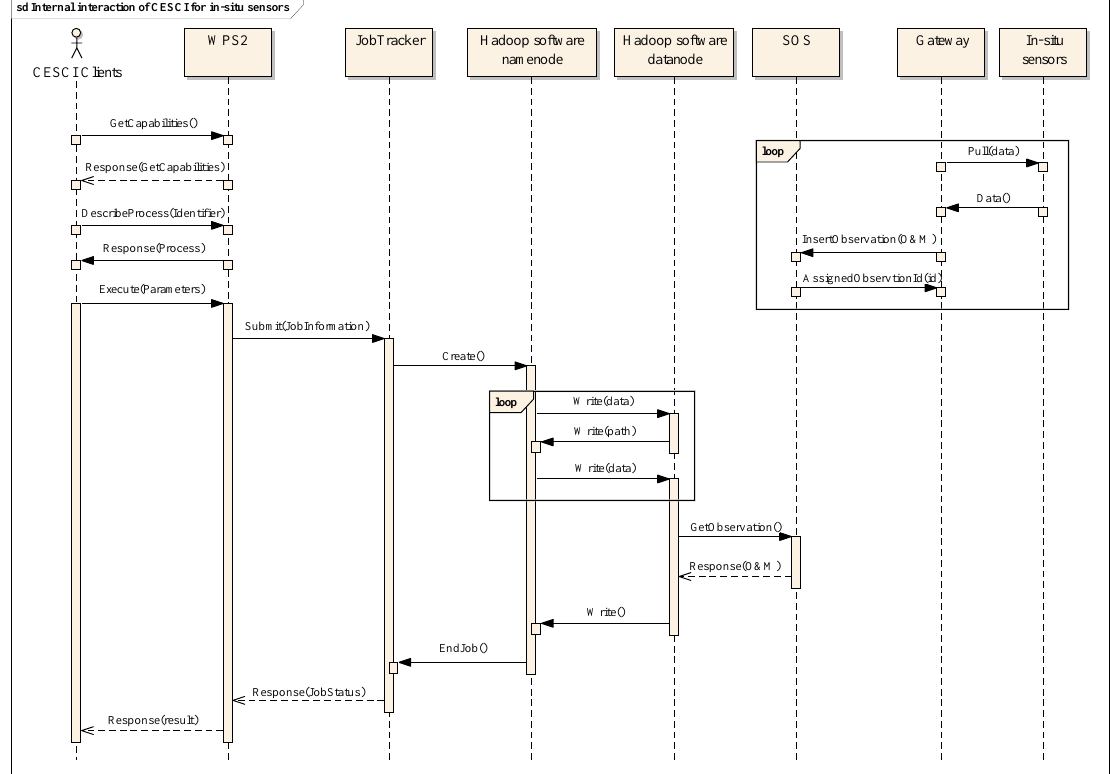
Figure 4. Web service operation flow in SM monitoring.